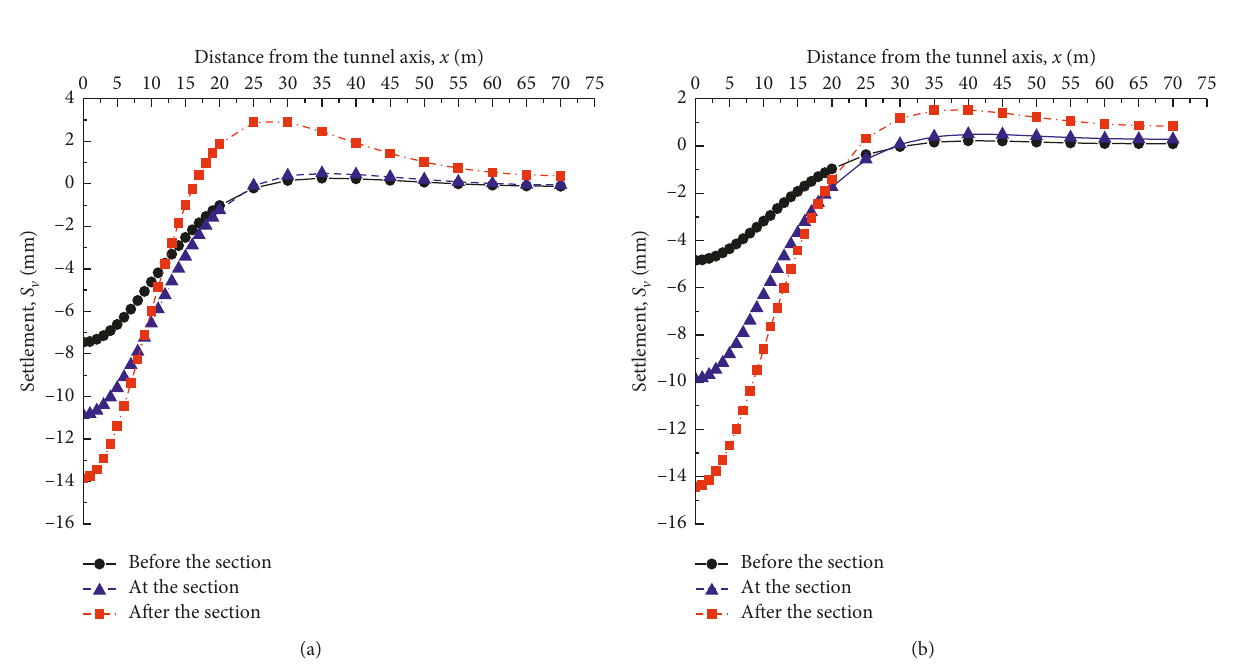
Figure 19: Surface settlement troughs at various stages: (a) DK17 +885; (b) DK17